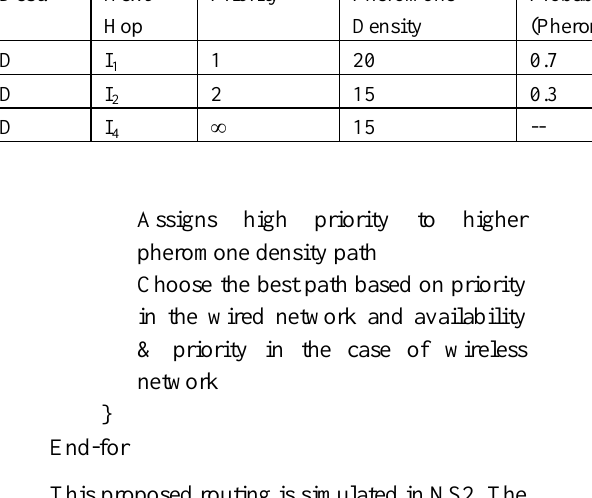
Table 1: Routing Table of Node ‗S‘ in case of Single path routing algorithm Dest. Next Hop Priority Pheromone Availability Status Density 20 Available Route Selected 15 Available Route in wait list 15 Not Available Routes Removed Table 2: Routing Table of Node ‗S‘ in case of Multi path routing algorithm Dest. Pheromone Probability Density (Pheromone) Available Available Not Available Routes